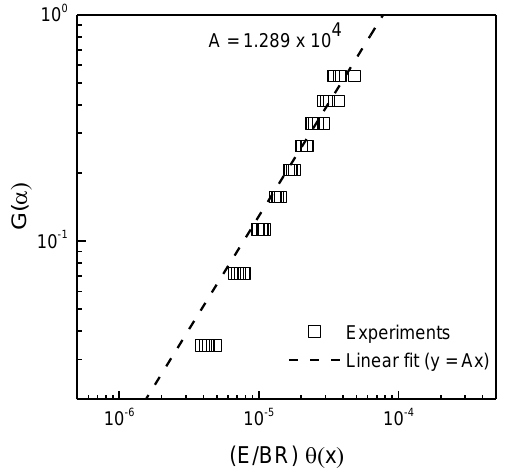
Figure 4. Determination of pre-exponential parameter A by linear fit to the experimental data.